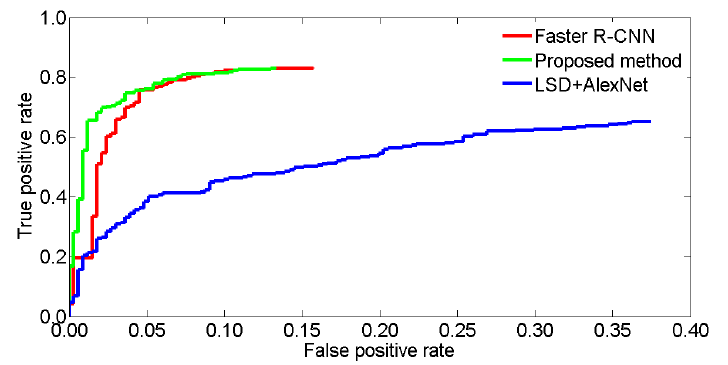
Figure 12. ROC graphs.